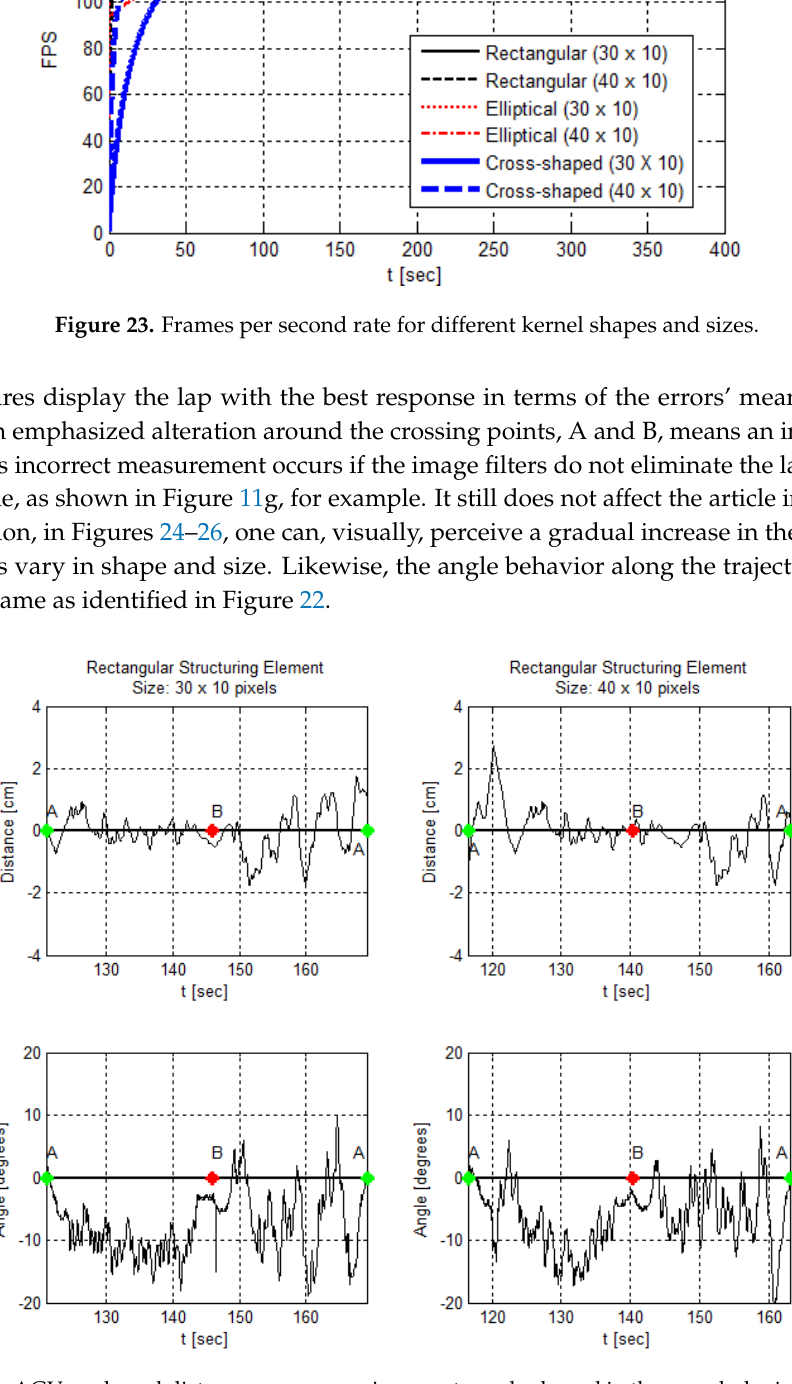
Figure 24. AGV angle and distance measures using a rectangular kernel in the morphological operation at the image processing